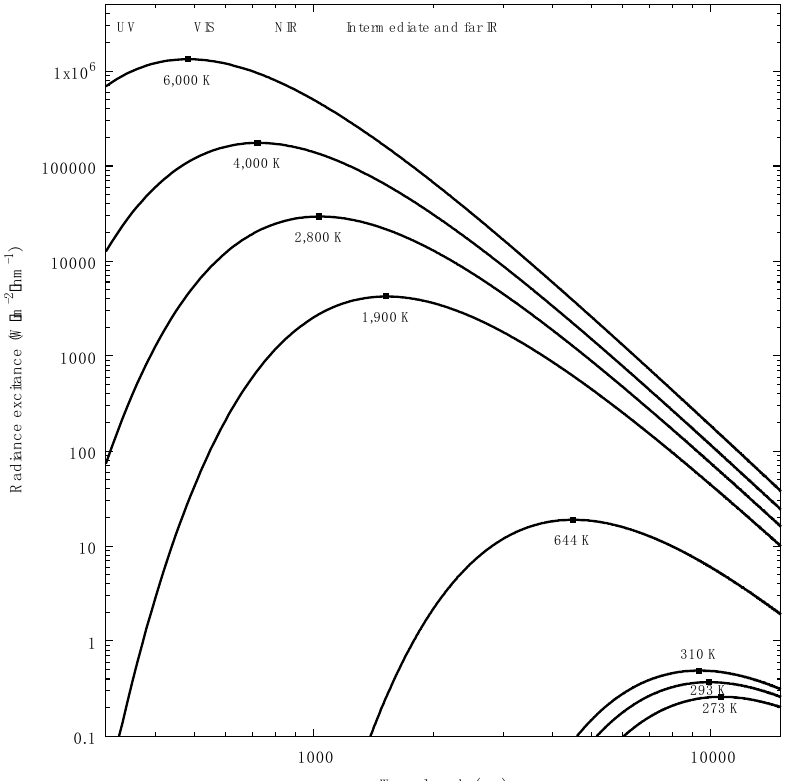
Figure 1. Spectral emission from ideal Planckian radiators heated at different temperatures (solid black lines), and spectral bandwidths commonly used for forensic imaging (colour rectangles). Square markers indicate the maximum amplitude ( λ max ) for each spectrum: daylight (correlated colour temperature of 6500 K), halogen–tungsten filament (4000 K), 75 W house bulb (2800 K), wax candle (1900 K), hot plate for technical purposes heated at about 370 ◦ C (644 K), human body at 37 ◦ C (310 K), and a black body heated at 20 ◦ C (293 K) and 0 ◦ C (273 K). Note how some sources emit radiation across several spectral bands: ultraviolet (UV), visible (VIS), near infrared (NIR), and intermediate and far infrared. Spectral bands cover the sensitivity range of most common imaging devices used for forensic and technical applications in the ultraviolet, visible, and infrared regions of the electromagnetic spectrum [2,10,11,19,21].